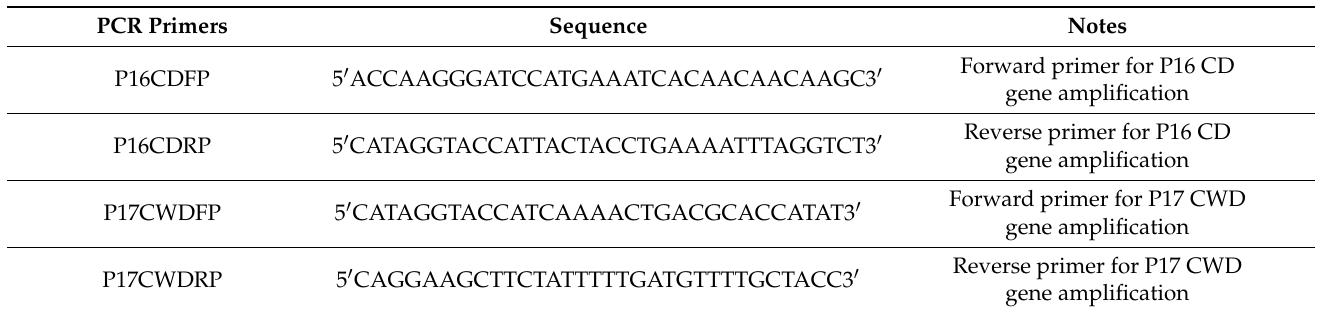
Table 1. Primers used for the